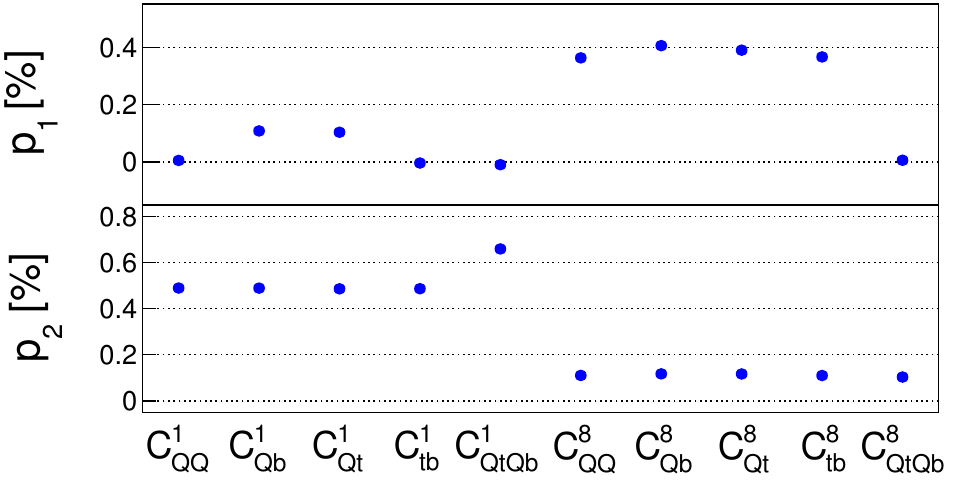
Figure 2 . Coe(cid:14)cients of the (cid:12)t to the cross section in the (cid:12)ducial detector volume, for di(cid:11)erent EFT operators turned on one by one. The (cid:12)t function has the form (cid:27) (cid:12)t = (cid:27) SM In this notation (cid:27) SM represents the SM cross section, p 1 signi(cid:12)es the fractional importance of the interference of the EFT with the SM and p 2 represents the fractional pure EFT contribution to the cross section at quadratic order in the coupling strength of the EFT